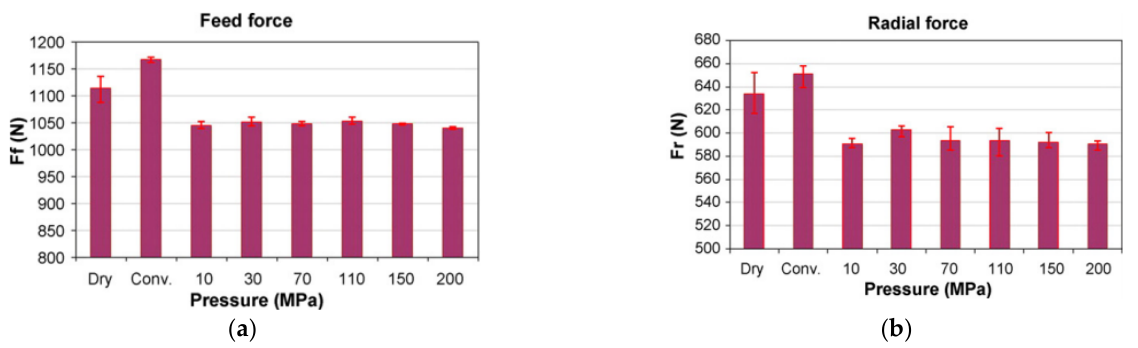
Figure 9. The effect of coolant pressure on ( a ) the feed force, and ( b ) the radial force [79].